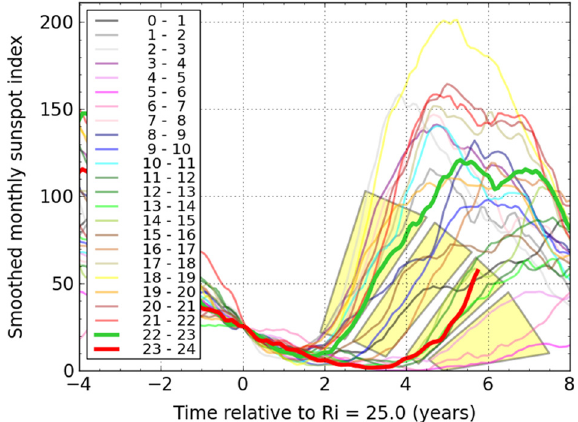
Fig. 3. Superposed-epoch plot of the R i index obtained by aligning all solar cycles 0–23 on their R i = 25 crossing point in the final decaying phase of the cycle (NB: Curves are numbered according to the cycles preceding and following the minimum). This represen- tation allows us to compare directly the length and depth of the solar minima. Thick lines highlight the 22–23 minimum (green) and the last minimum 23–24 (red). The four shaded boxes mark four families of cycles according to the steepness of the rise following the minimum: fast, moderate, late and weak (top to